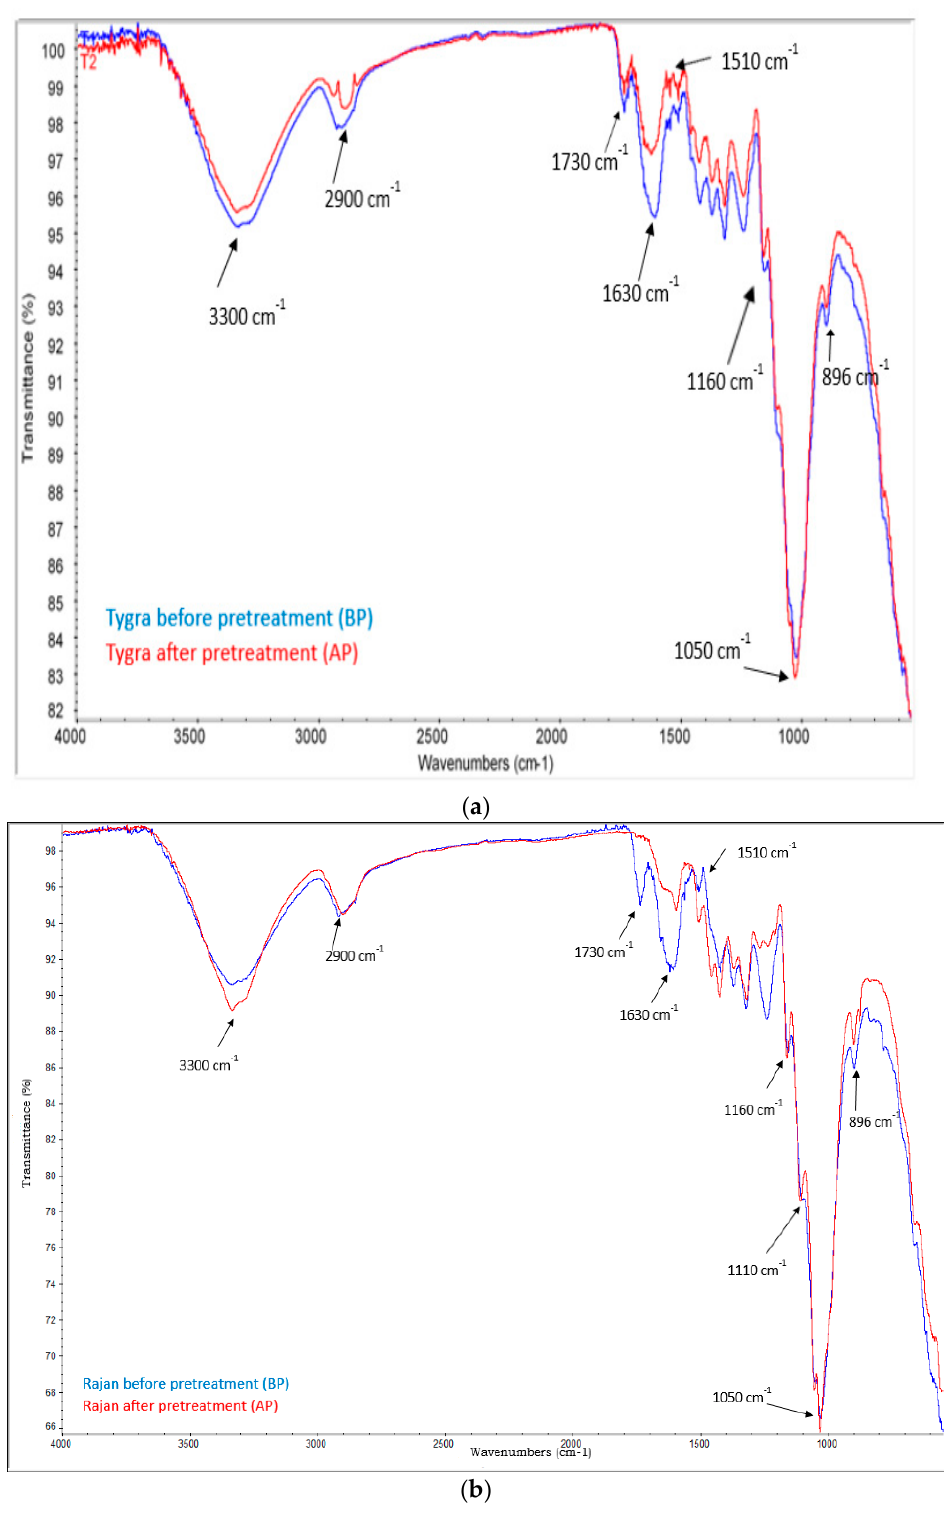
Figure 1. ( a ) The FTIR spectra of the Tygra biomass before and after the alkaline treatment. ( b ) The FTIR spectra of the Rajan biomass before and after the alkaline treatment.